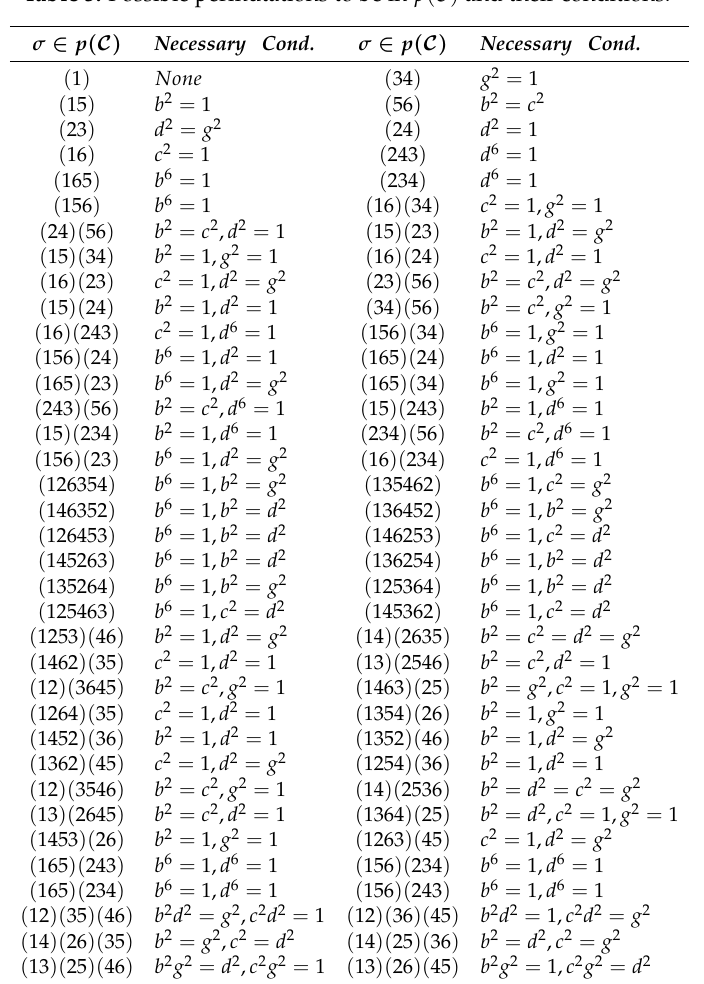
Table 3. Possible permutations to be in p ( C ) and their